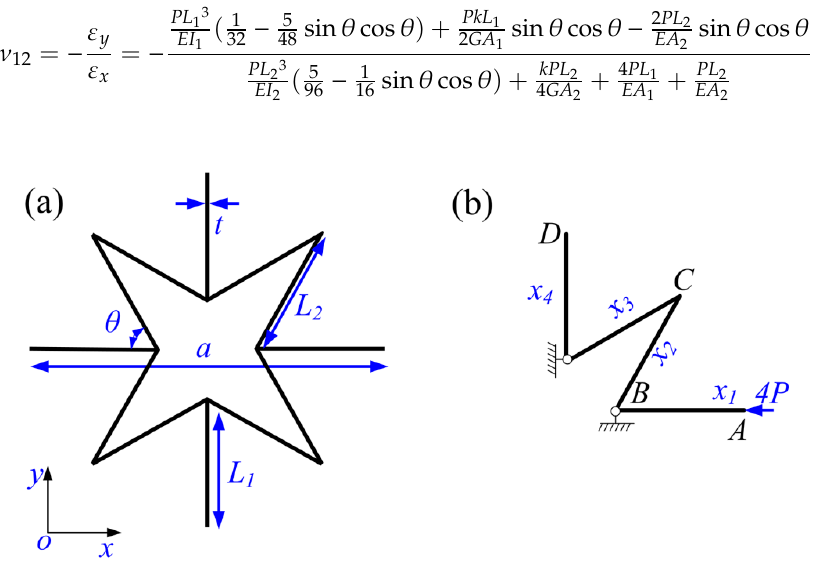
Figure 2. ( a ) The simplified 2D star structure and ( b ) the equivalent representative connected walls under horizontal force 4P acting at point A .